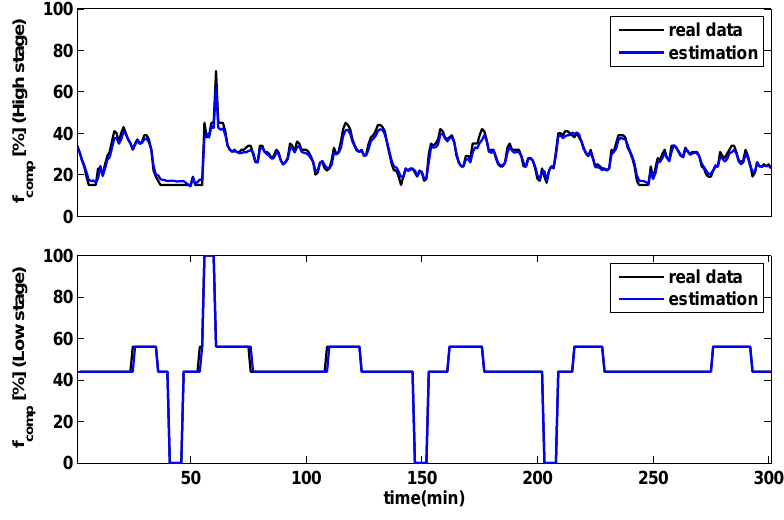
Figure 12. Estimation of compressor capacity such that the suction pressure and low-side pressure are regulated to 26 × 10 5 [pascal] and 14 × 10 5 [pascal],